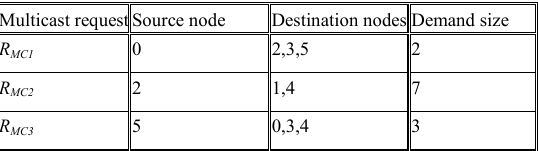
TABLE 4. The given multicast requests in light-trail networks for scenario 1